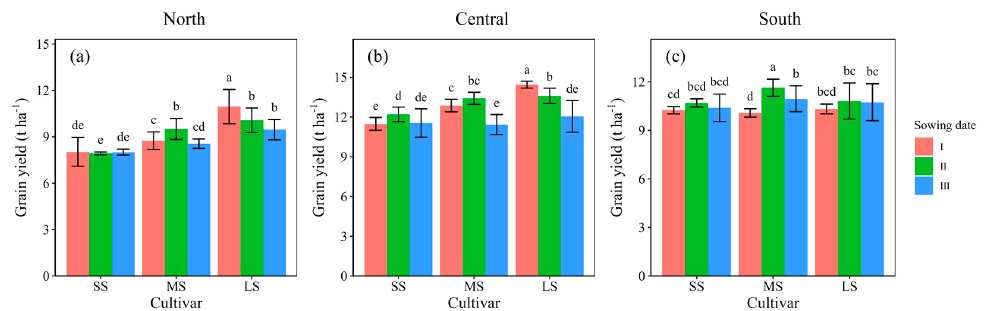
Figure 3. Grain yields of different cultivars and sowing dates in the Northeast China Plain: ( a ) North, Keshan station; ( b ) Central, Gongzhuling station; ( c ) South, Shenyang station. SS: short-season cultivars; MS: medium-season cultivars; LS: long-season cultivars; I: early sowing date; II: medium sowing date (traditional sowing date); III: late sowing date. Different letters above the error bars are significantly different at the 0.05 probability level. Bars represent the standard errors.